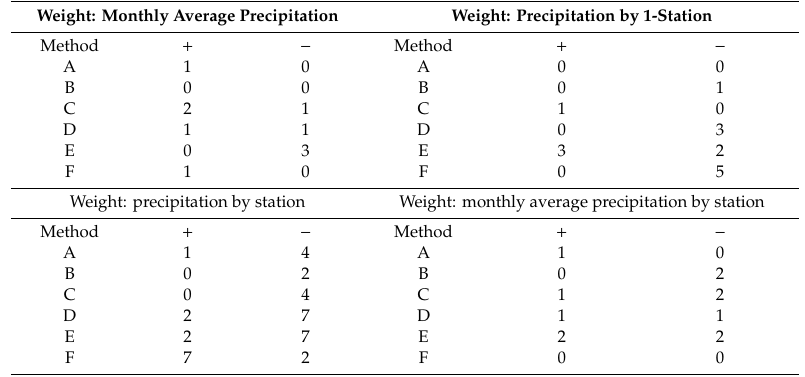
Table 3. Results of increase and decrease of rank after application of weighted entropy.